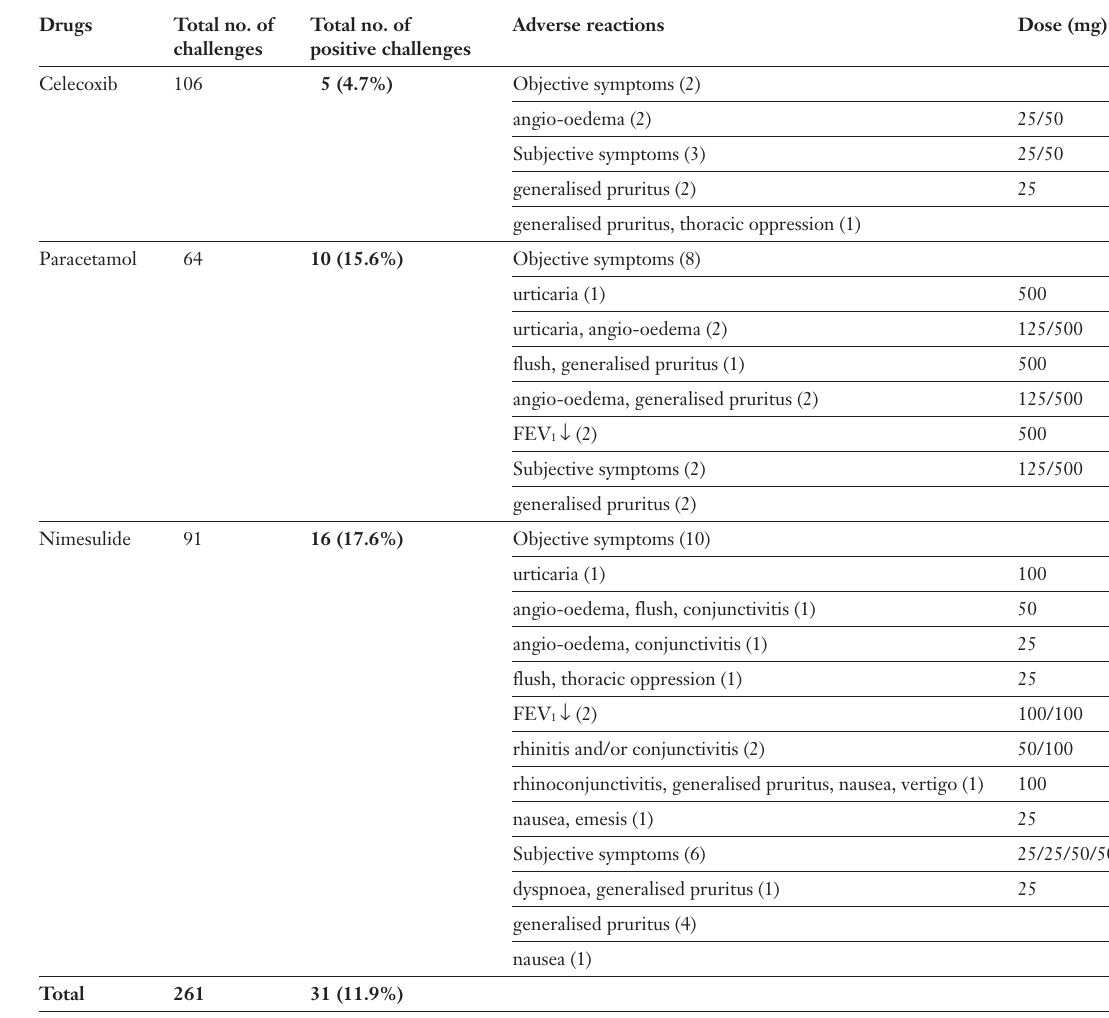
Table 3 Results of oral chal- lenge with celecoxib, paracetamol and nimesulide.